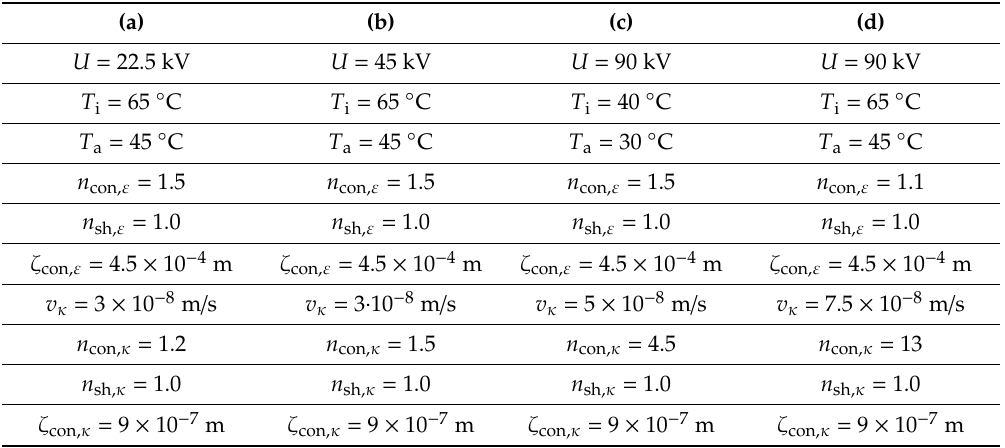
Table3. Characteristicvaluesfor(49)and(50),